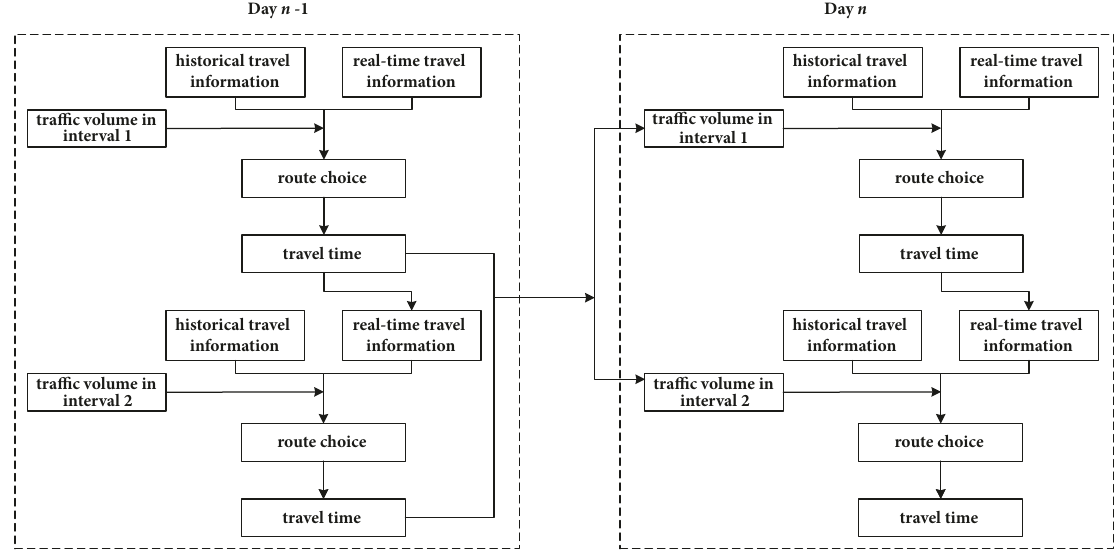
Figure 2: Evolution of network traffic flow on two-link network with a study period divided into two